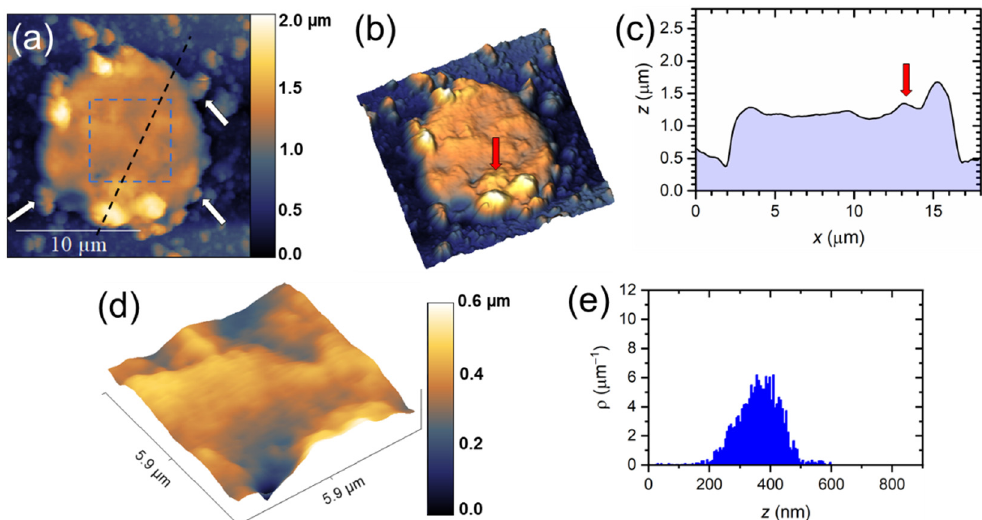
Figure 4. Representative AFM image of an acute lymphoblastic leukemia cell cultured on the TiO 2 -m coating for 40 min. ( a ) Two-dimensional and ( b ) three-dimensional topography images. ( c ) Height profile taken along the dashed line in ( a ). The white arrows in ( a ) indicate pseudopodia formation. Protrusions inside the cell can be identified close to the membrane boundary (red arrows in ( b , c )), which may result from internalization of TiO 2 -m nanoparticle aggregates. ( d ) Three-dimensional representation of the zoomed area indicated by the dashed square in ( a ). ( e ) Height distribution function calculated for the zoomed image shown in ( d ). The height z = 0 nm corresponds to the lowest height value within the zoomed region in ( d ).